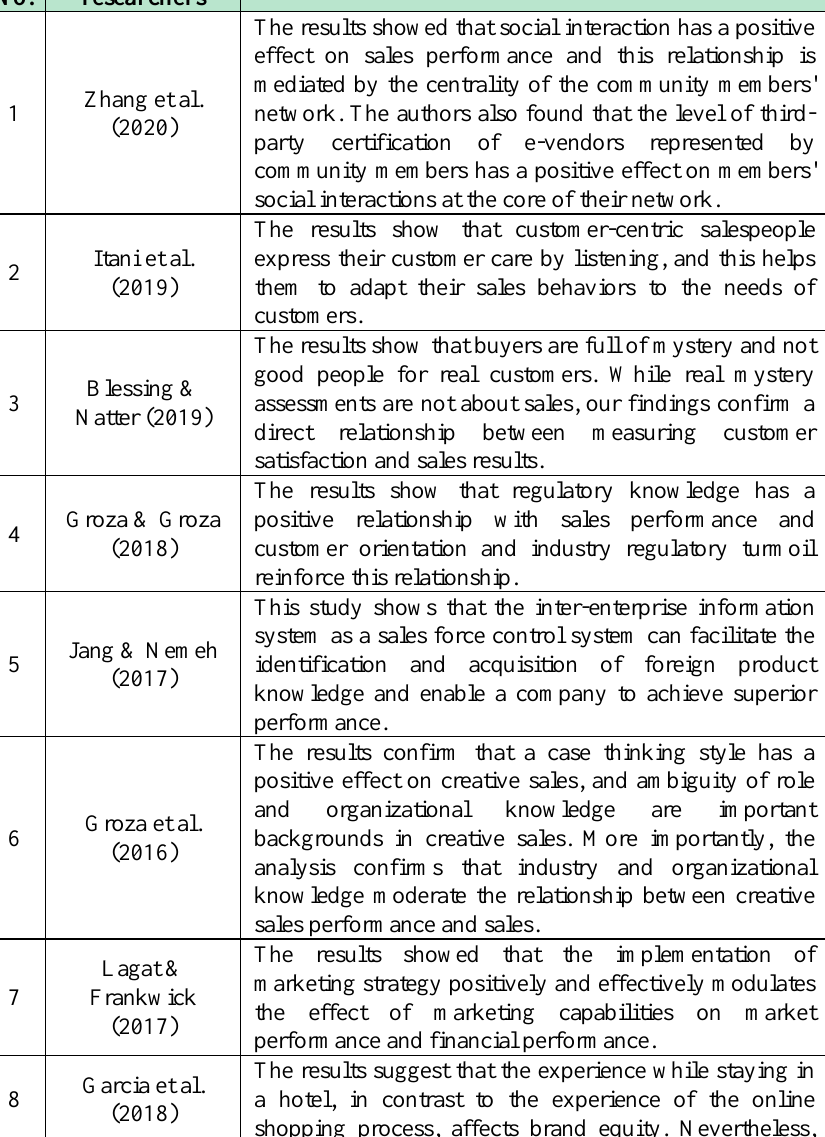
Table1. Overview of studies on research